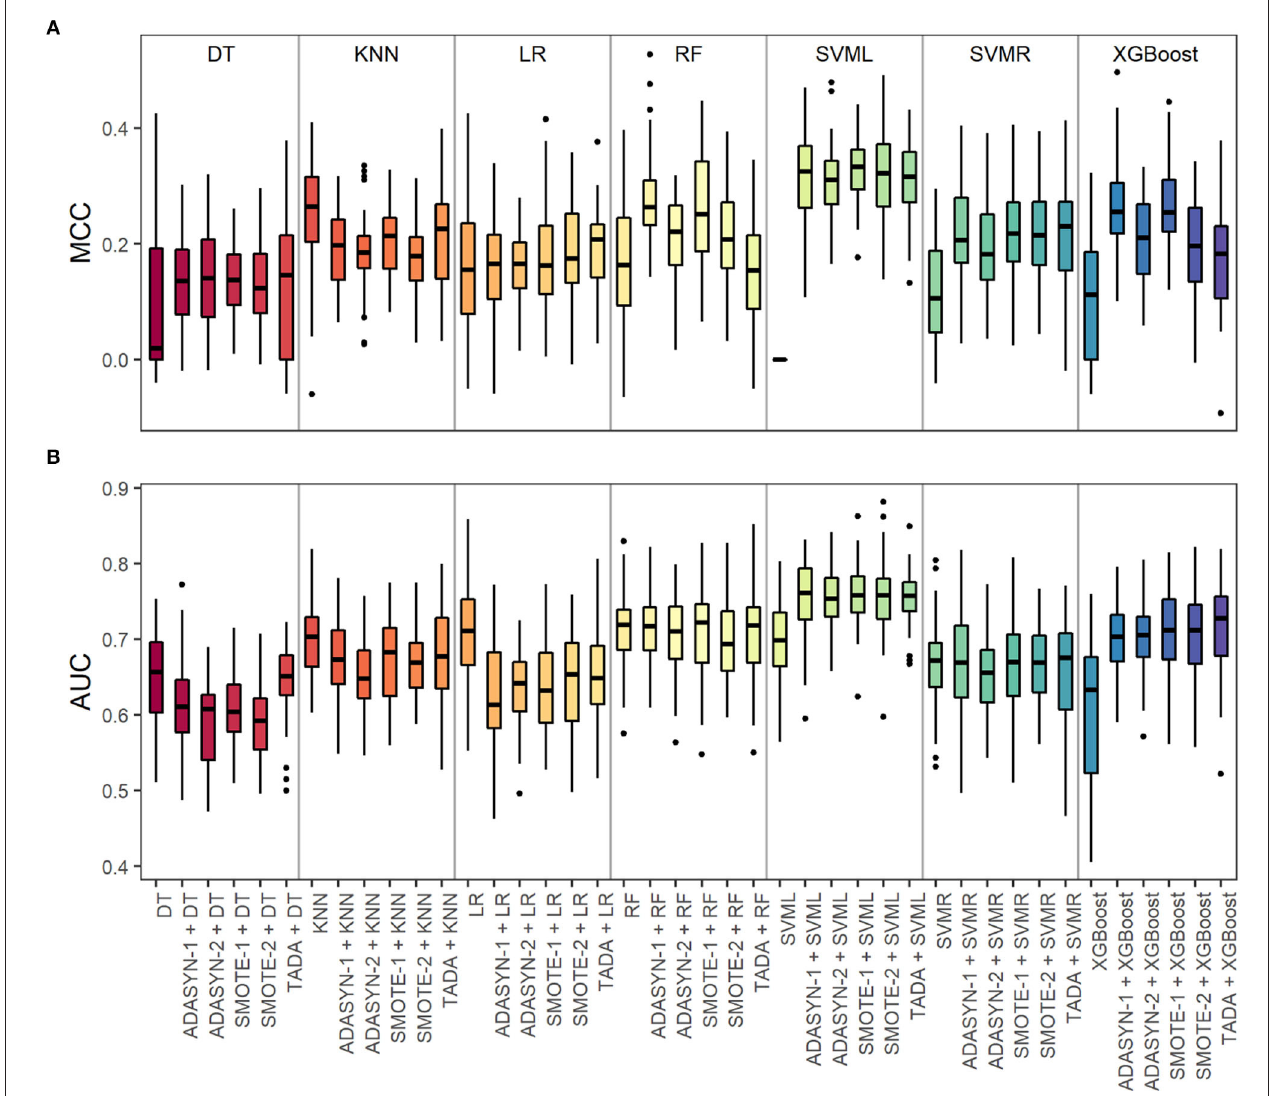
FIGURE 2 | Validation of data types with machine learning (ML) methods for microbiome-based prediction of smoking habits based on the S1 and S2 datasets together. For each ML method, we evaluated six types of input data: baseline non-augmented and five augmented datasets based on different methods (ADASYN-1, ADASYN-2, SMOTE-1, SMOTE-2, and TADA). (A) Matthews correlation coefficient (MCC) and (B) area under the receiver operating characteristic curve (AUC) values from the 5-fold nested crossed-validation were repeated for 10 times (5 * 10). For MCC, + 1 represents a perfect prediction, 0 random prediction, and − 1 perfect inverse prediction. For AUC, 1 indicates perfectly accurate prediction and 0.5 indicates random prediction. ML method abbreviations: DT, decision trees; KNN, k-nearest neighbors; LR, logistic regression; RF, random forest; SVML, support vector machine with linear kernel; SVMR, support vector machine with radial kernel; XGBoost, extreme gradient